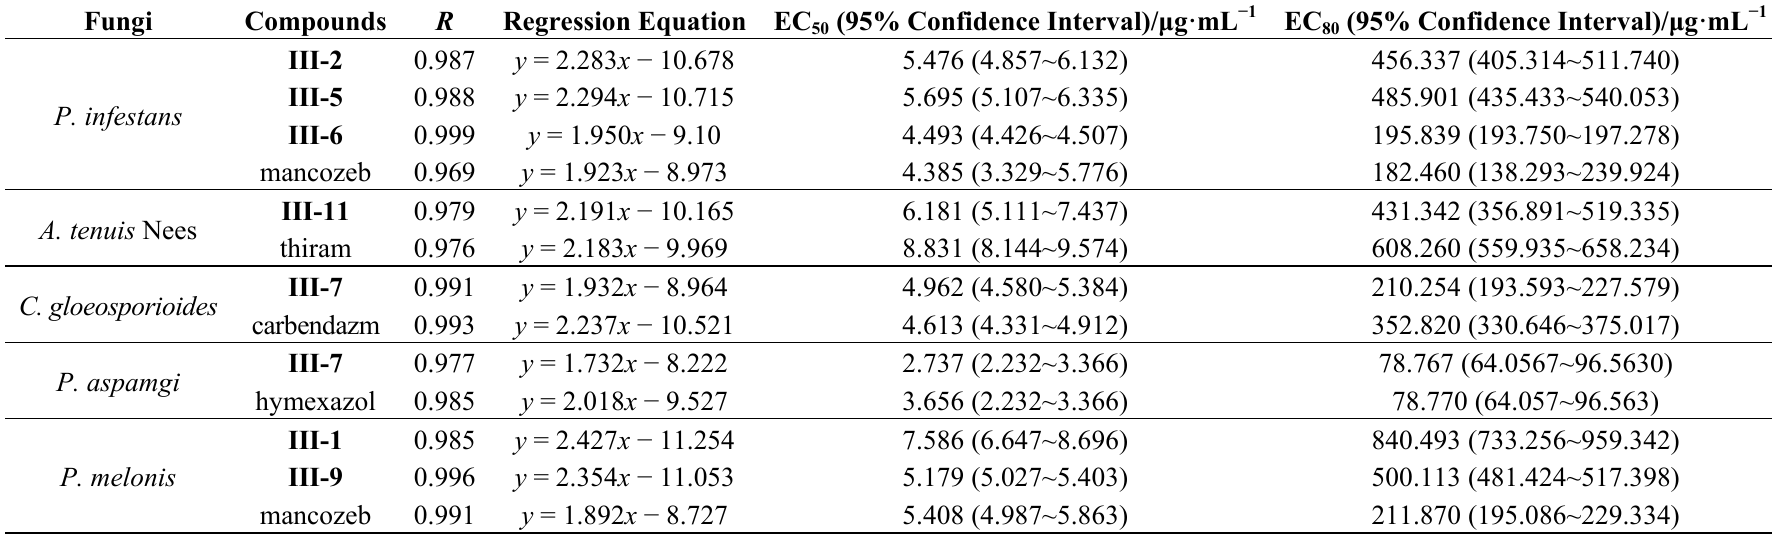
Table 3. Fungicidal activity of title